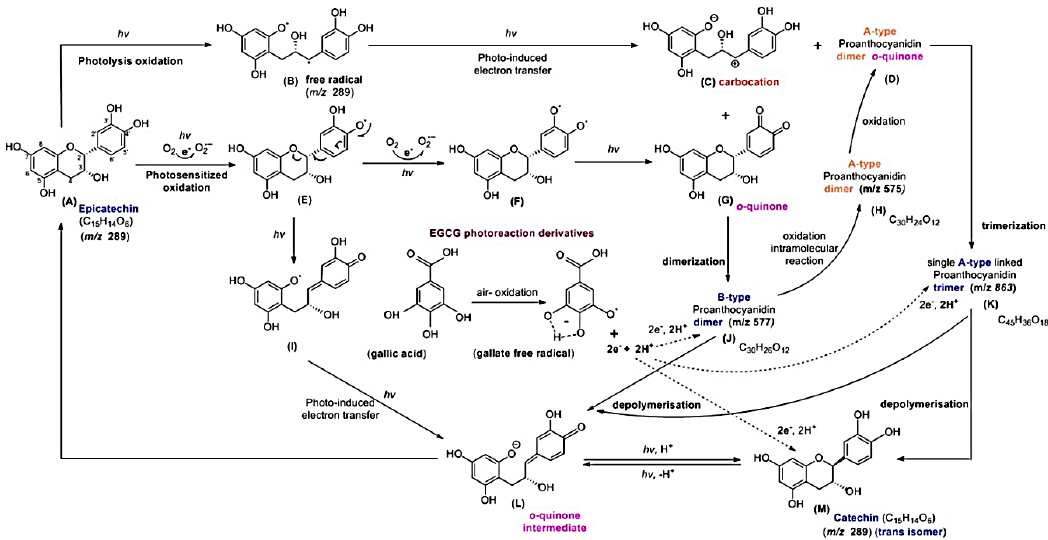
Figure 9. Proposed scheme for the mechanism of the EC photoreaction and the interactions of the intermediates with EGCG.